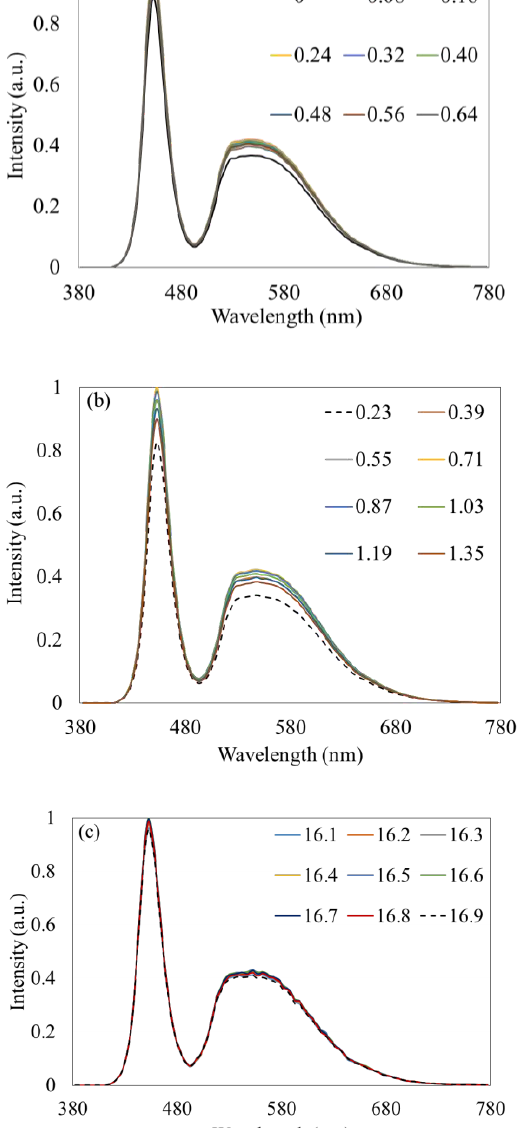
Figure 4 : The luminous output of WLEDs at the same CCT in cases of d 1 (a), d 2 (b) and r 2 (c) For the CDRP structure, the concave surface favorably backscatters light on the surface of the LED chip, so there is more misplaced radiated light energy. This clarifies for